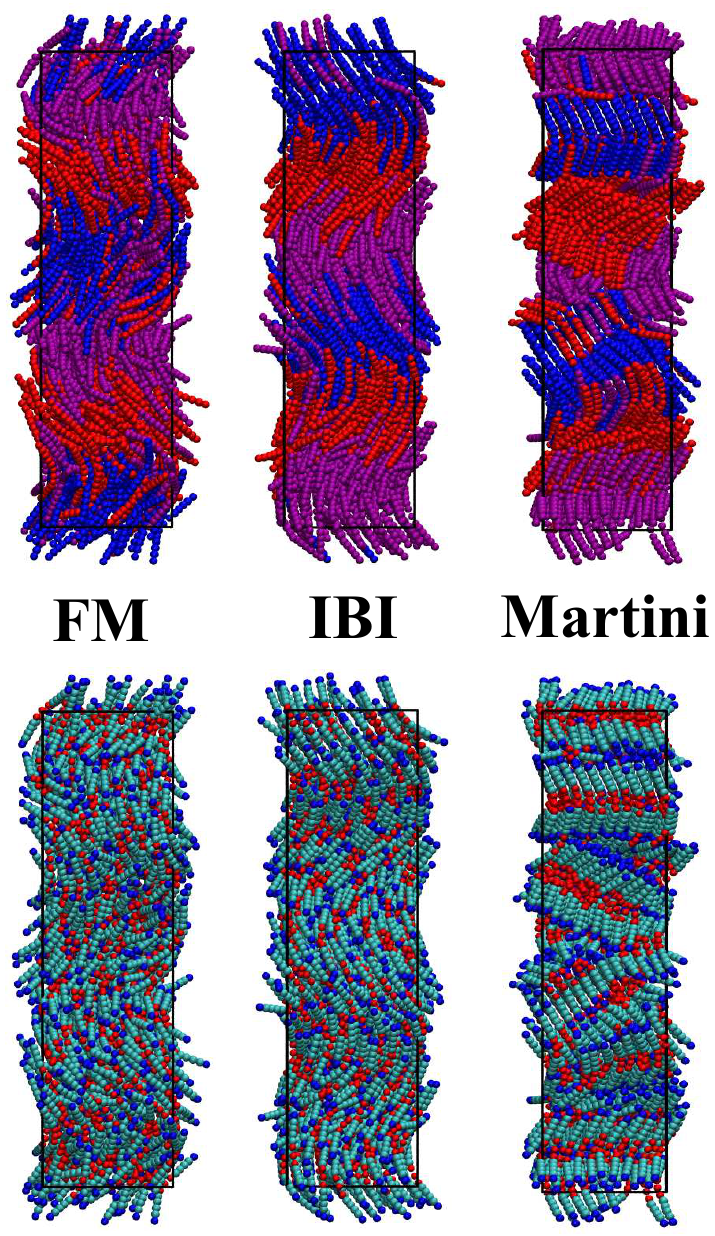
Figure 3. Simulation snapshots of coarse-grained models of CB7CB at 370 K for the FM, IBI and Martini 3 CG models. ( Top ): Colouring by molecular orientation. ( Bottom ): Colouring according to bead